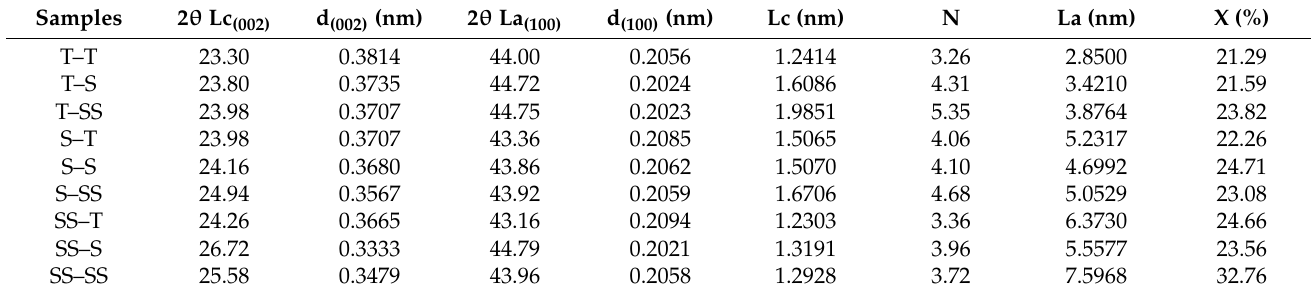
Table 2. XRD parameters of activated carbon prepared by thermal, saturation and